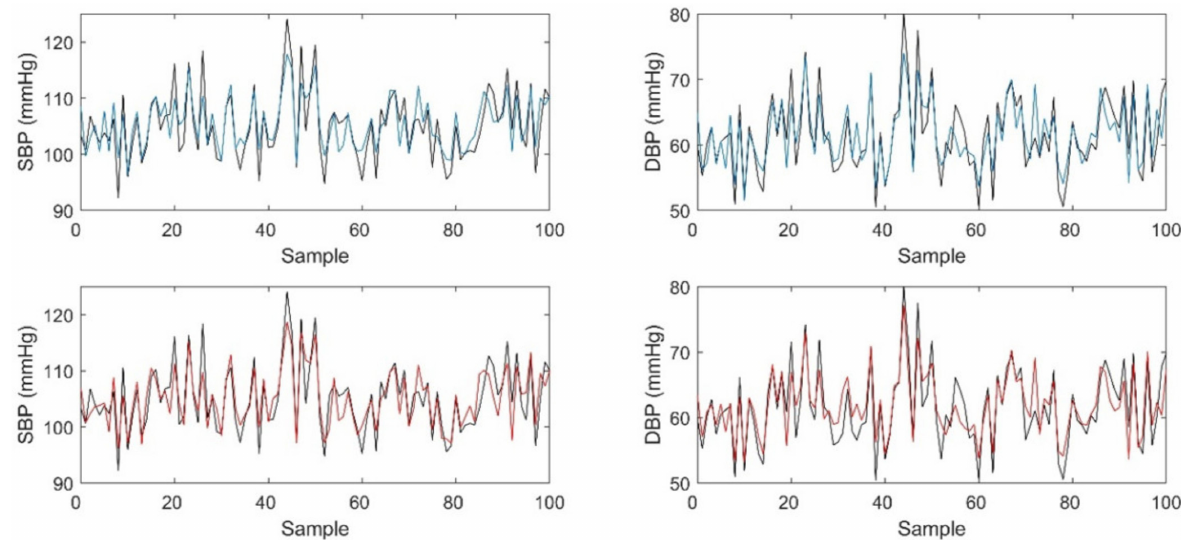
Figure 5. Comparison of reference and estimated BPs (black line: reference BP; blue line: personal model; red line: tuned leave-one-subject-out (LOSO) model).